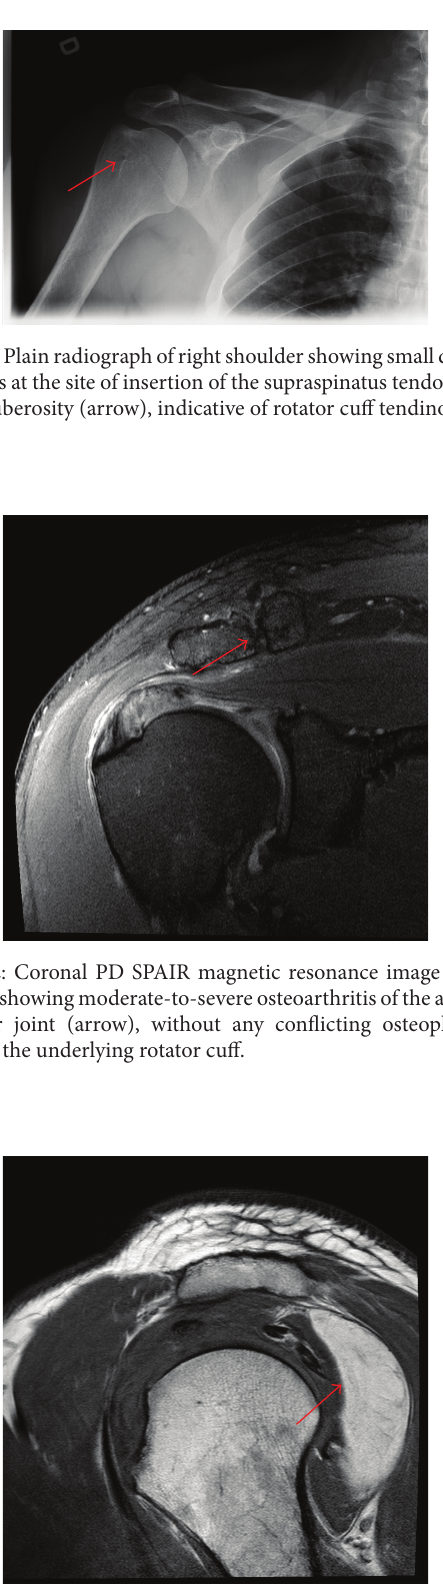
Figure 3: Sagittal T1 TSE magnetic resonance image of right shoulder showing a homogenous lesion (arrow) compatible with an intermuscular lipoma under the posterior aspect of the deltoid, extending to the undersurface of the